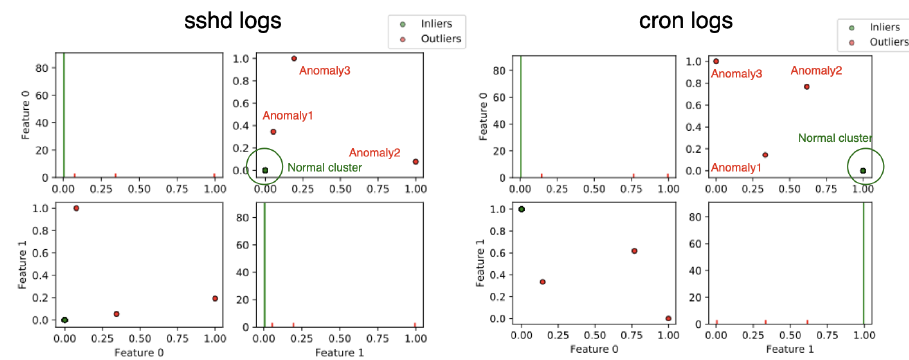
Figure 3: The distribution of two-dimensional word vectors for the sshd (left) and cron (right)